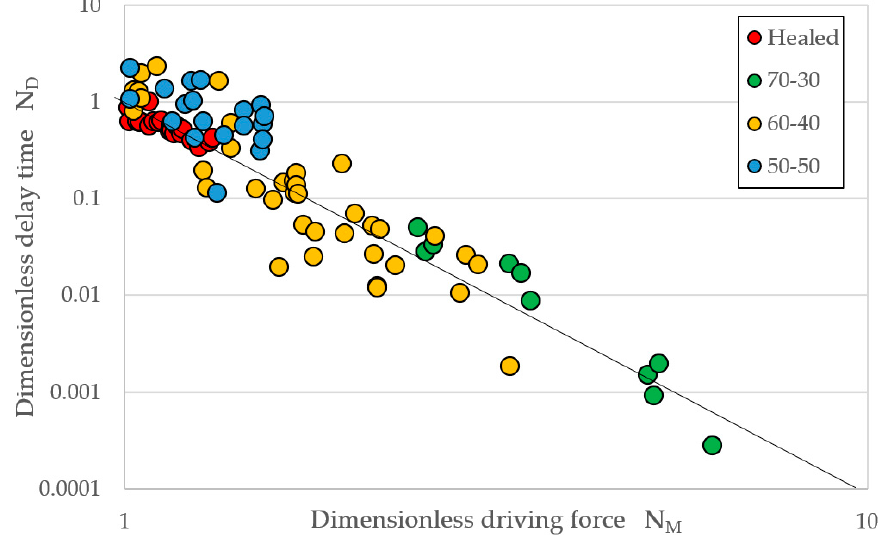
Figure 5. Relationship between dimensionless delay and driving force.